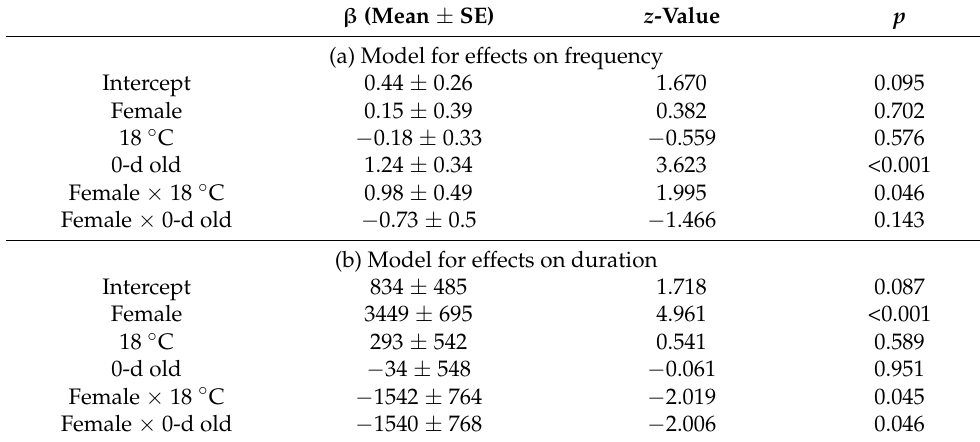
Table 2. Parsimonious generalized linear models selected by AIC for the effects of sex, temperature, and age on the frequency and duration of thanatosis in H. prosopidis . GLM indicates a reference group as an intercept. Here, the reference group is 2-d-old males at 25 ◦ C in models of both frequency and duration. β (Mean ± SE) z -Value (a) Model for effects on frequency